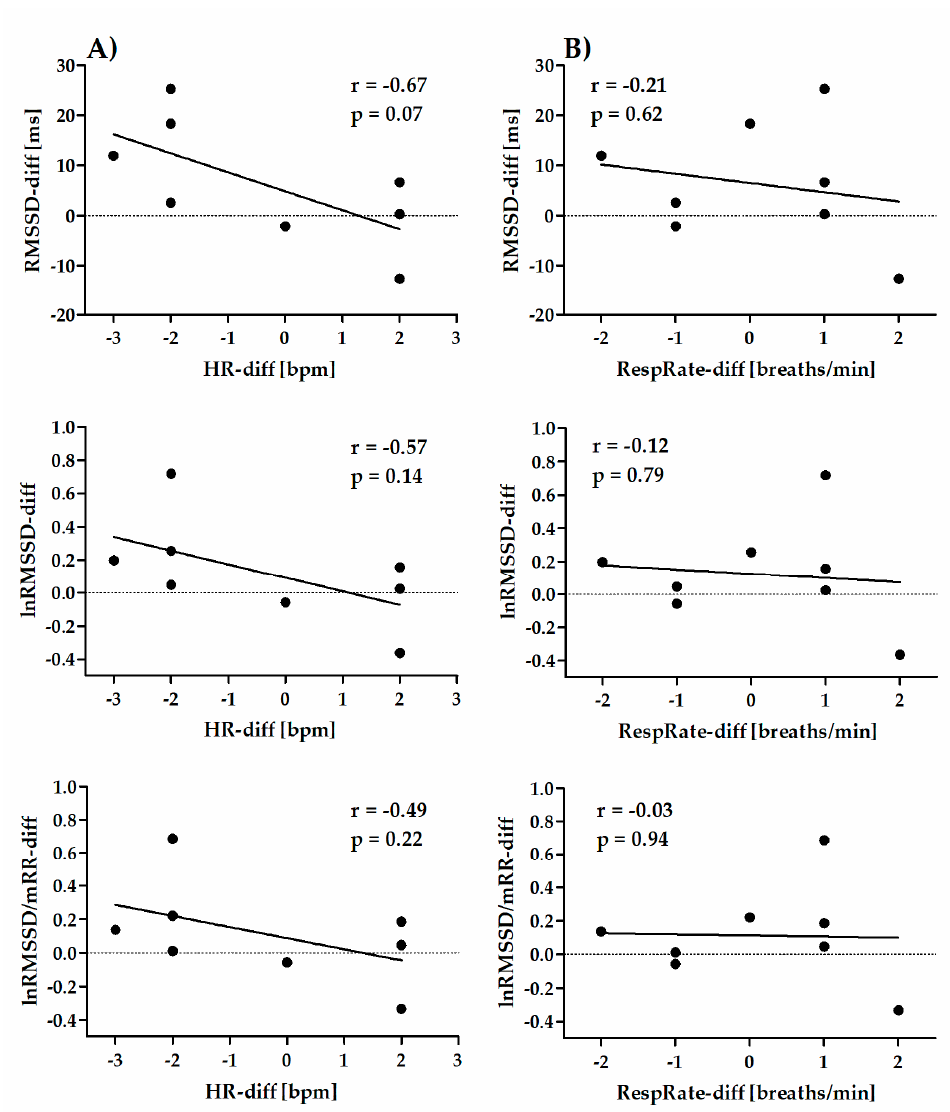
Figure 7. Pearson’s correlation coe ffi cient between Retest–Test di ff erences in ultra-short-term (1 min) HRV parameters and di ff erences in ultra-short-term (1 min) HR (HR-di ff ) (column A ) or ultra-short-term RespRate (RespRate-di ff ) (column B ).